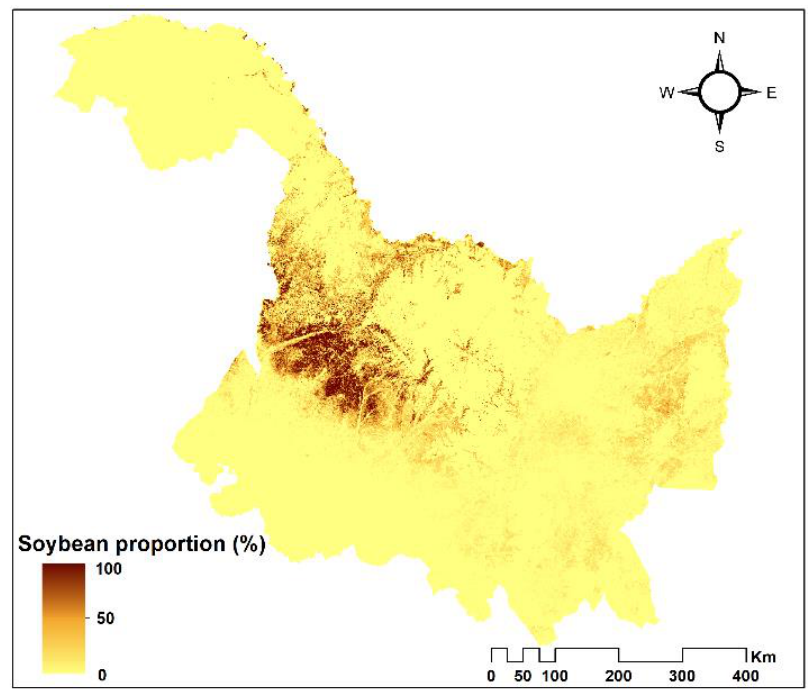
Figure 8. Sub-pixel proportion map of soybean cultivation in Heilongjiang province derived from the optimized GWR model.